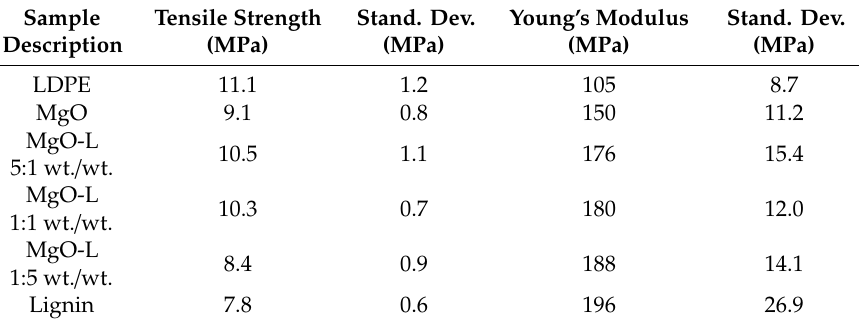
Table 1. Mechanical results of tested